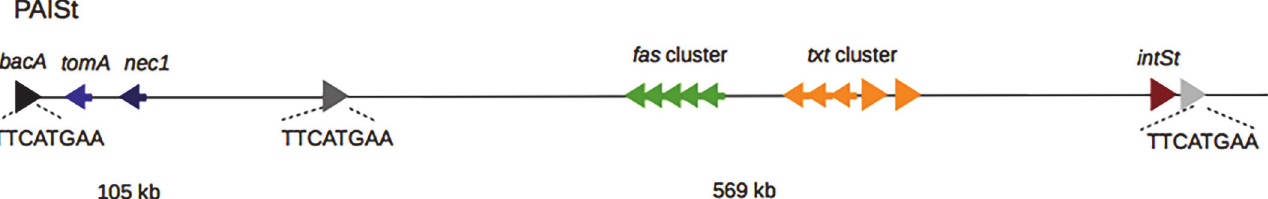
Fig 1. Schematic representation of the PAISt in S . turgidiscabies Car8. Copies of the 3 0 end of the bacitracin resistance gene ( bacA ) delimit the element in two modules of 105 Kb and 569 Kb. The virulence genes nec1 and tomA are located in the first module and the fasciation ( fas ) and thaxtomin ( txt ) biosynthetic clusters are located in the second module. The putative integrase ( intSt ) is located at the 3 0 end of the island. The 8 bp palidromic repeats are shown within the bacA gene and its truncated copies.